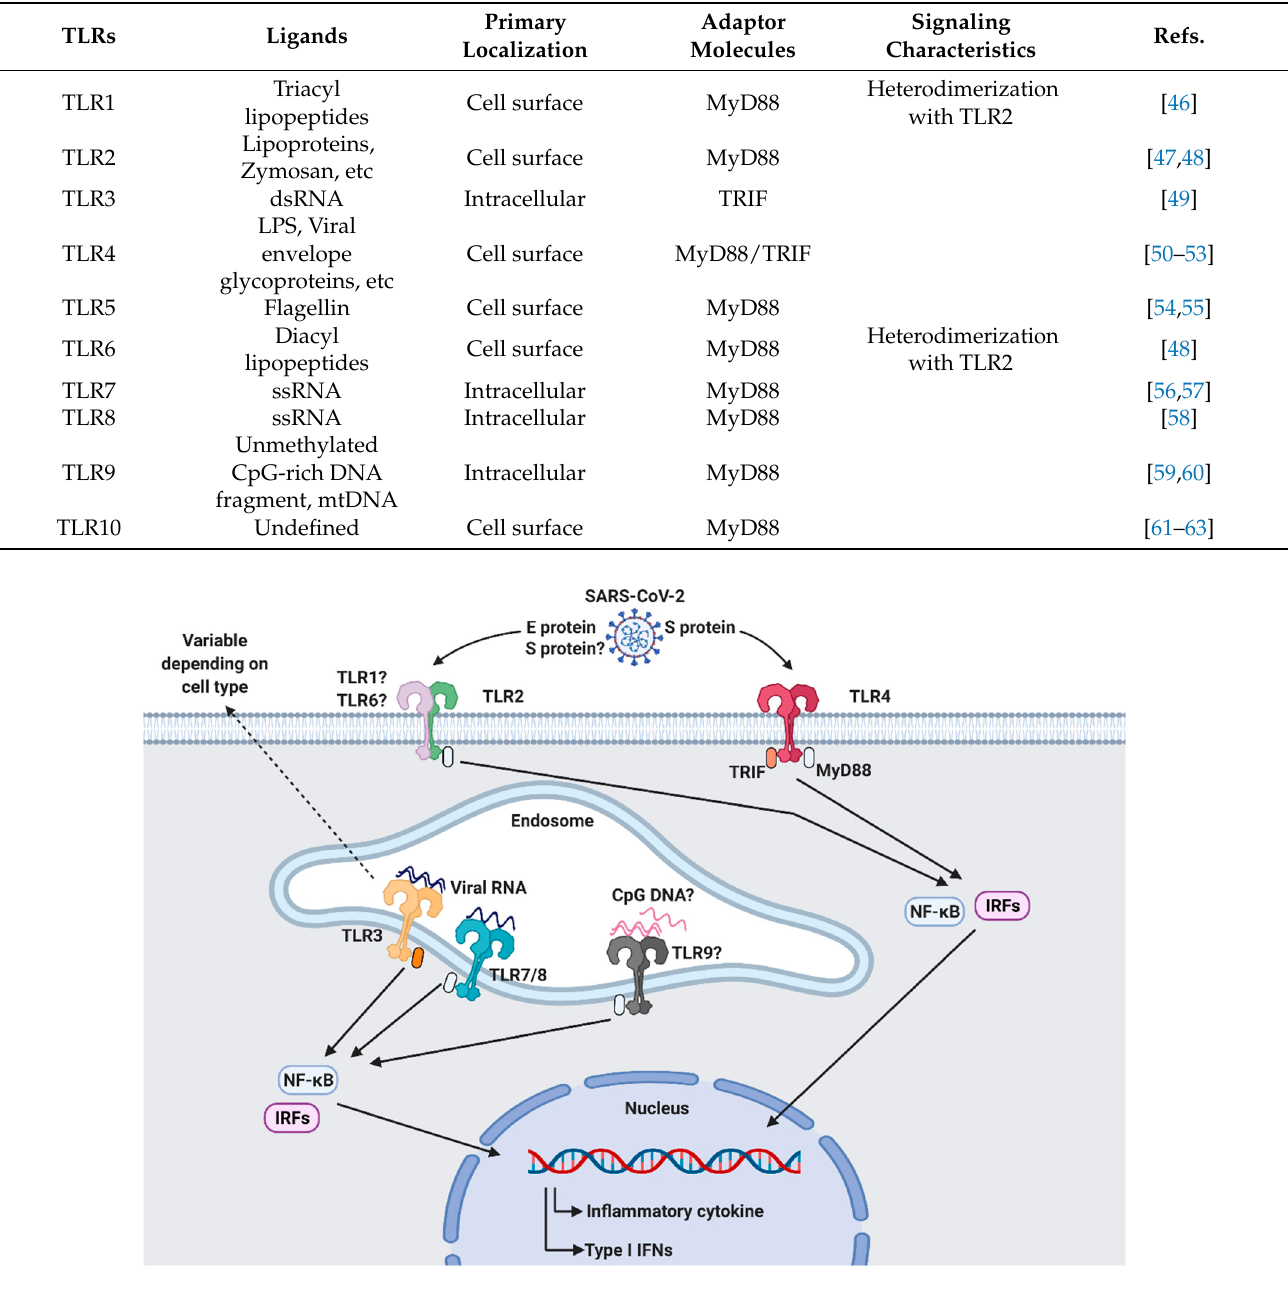
Table 1. Toll-like receptors (TLRs) in humans.